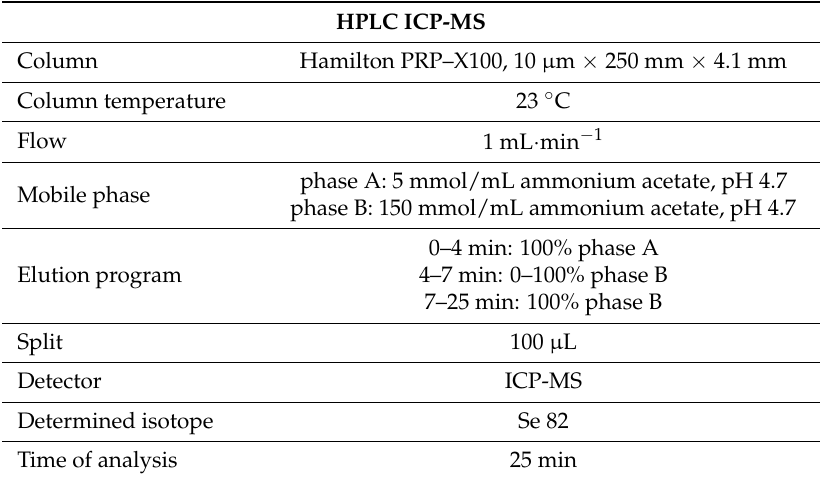
Table 2. Chromatographic separation procedure